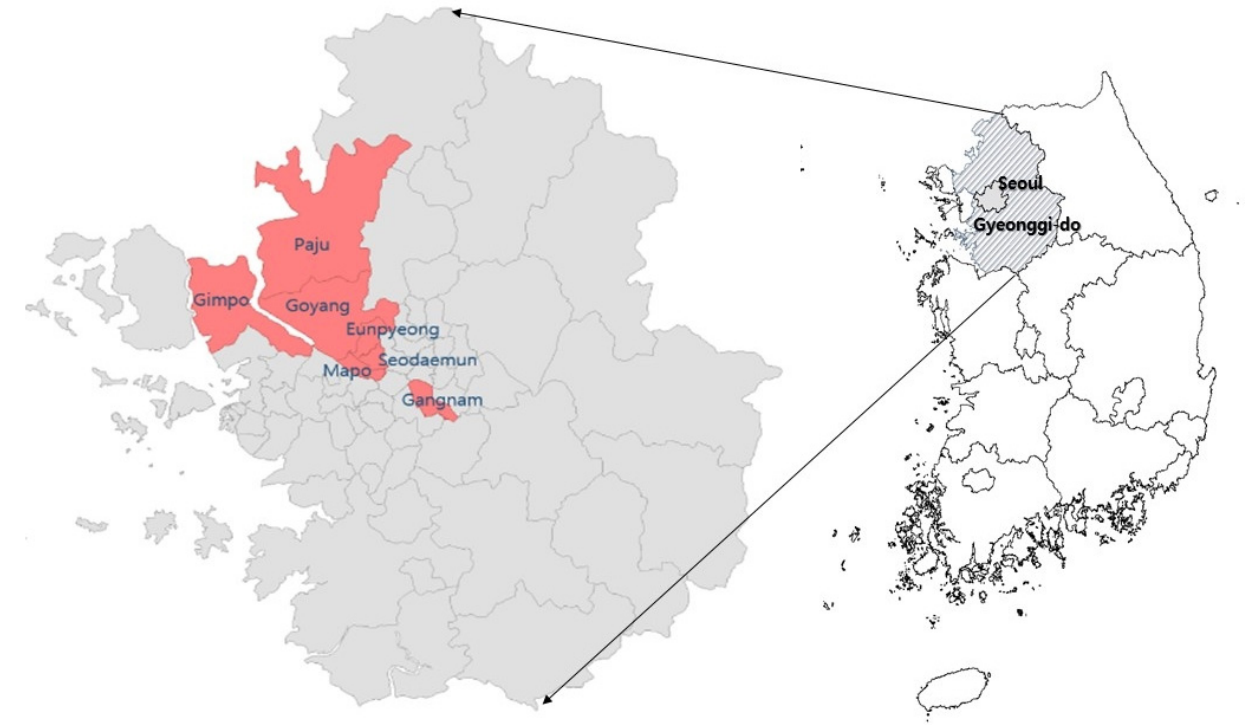
Figure 1. Research area.